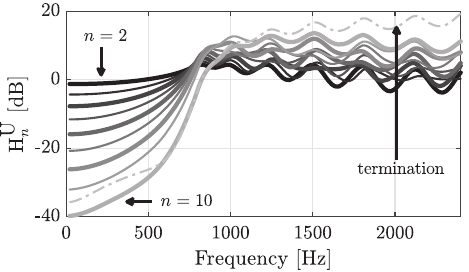
Figure 3. The transfer function between fl ow through the fi rst tonehole and fl ow through the n th (for n = 2 – 10) tonehole and open termination of a conical lattice with f G lattice geometry is Resonator 1 in the Appendix, and is the same lattice used for Figure